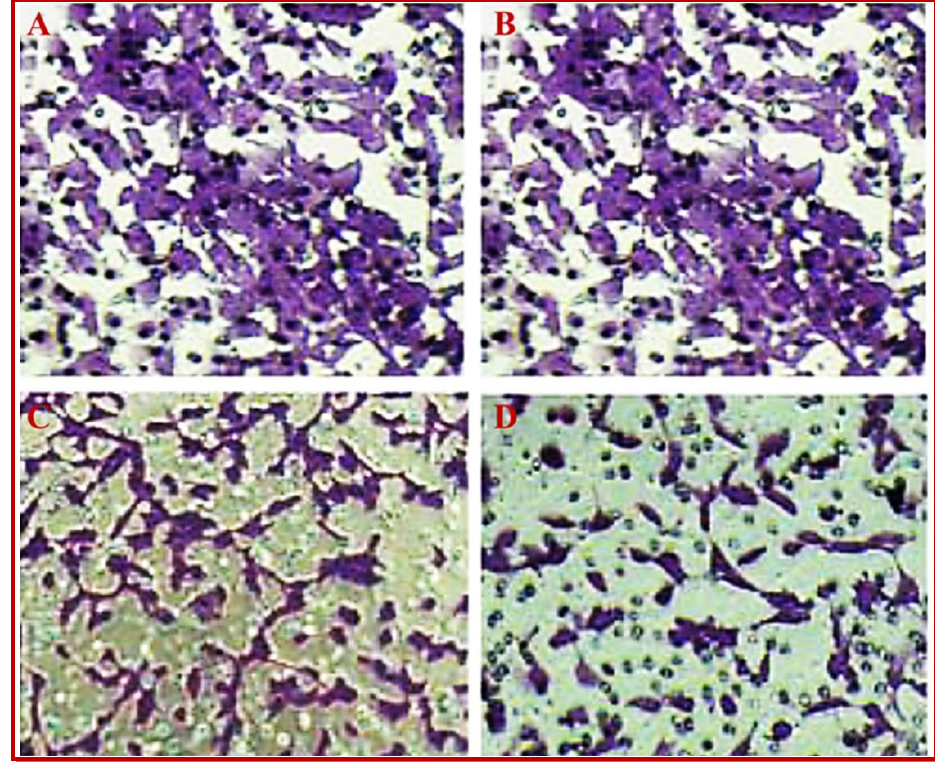
Figure 7: Theaflavin-3-gallate decreases invasion of A-549 non-small cell lung cancer cells. Invasion assay was carried out using modified 24-well microchemotaxis chambers. Then selected fields were photographed (x100), and the number of cells migrated to the lower surface was calculated as a percentage of invasion. A shows untreated normal cells, while as B, C and D represent effect of 20, 80 and 160 µM dose of theaflavin-3-gallate on cell invasion